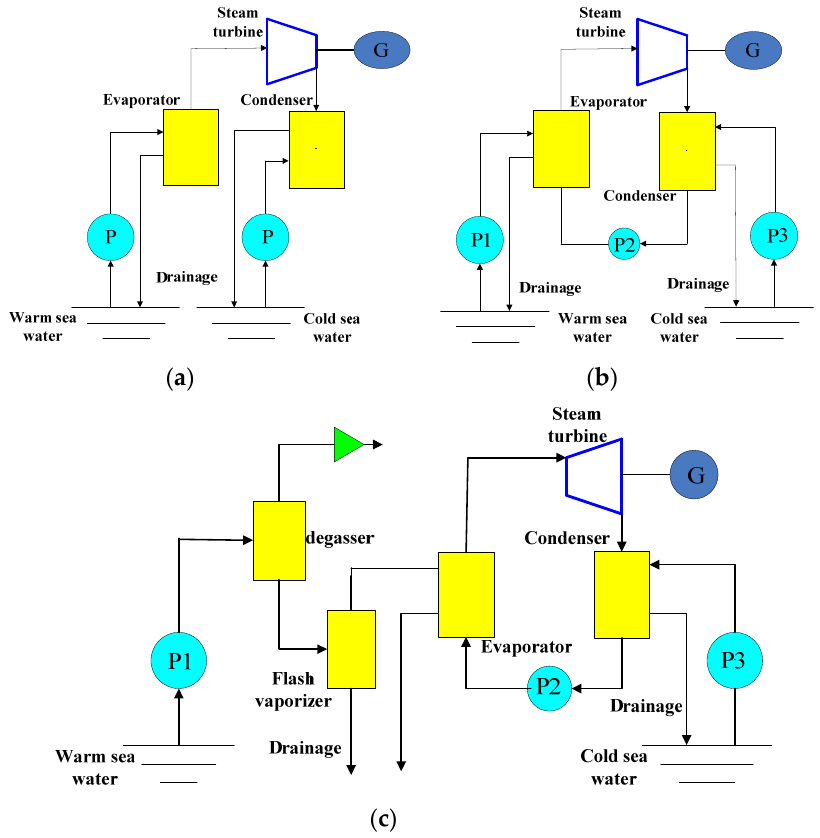
Figure 16. The principle diagram of ocean temperature difference power generation system: ( a ) Open cycle power generation system; ( b ) closed cycle power generation system; ( c ) hybrid cycle power generation system.